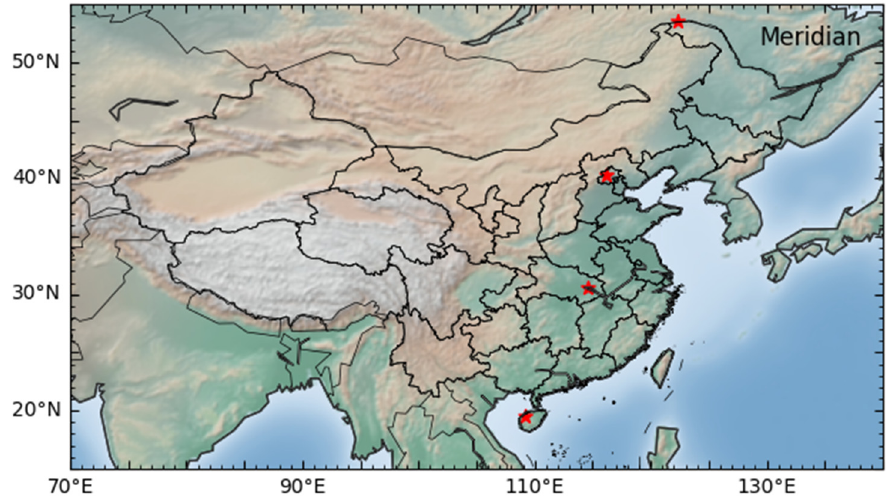
Figure 4. Geographical distribution of digisonde